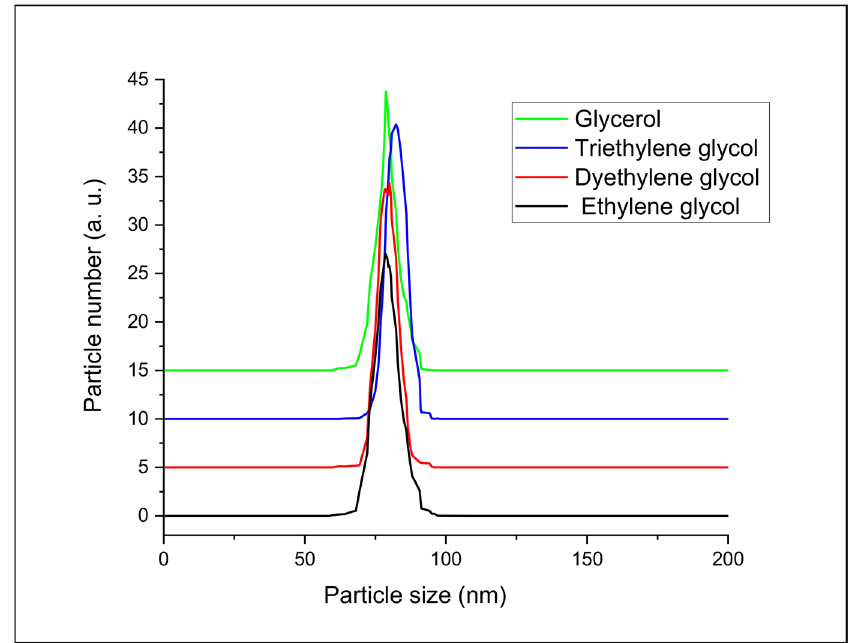
Figure 3. Size distribution of the nanoparticles after the synthesis. Curves are displaced by a multiple of five units each along the ordinate for the sake of clarity.